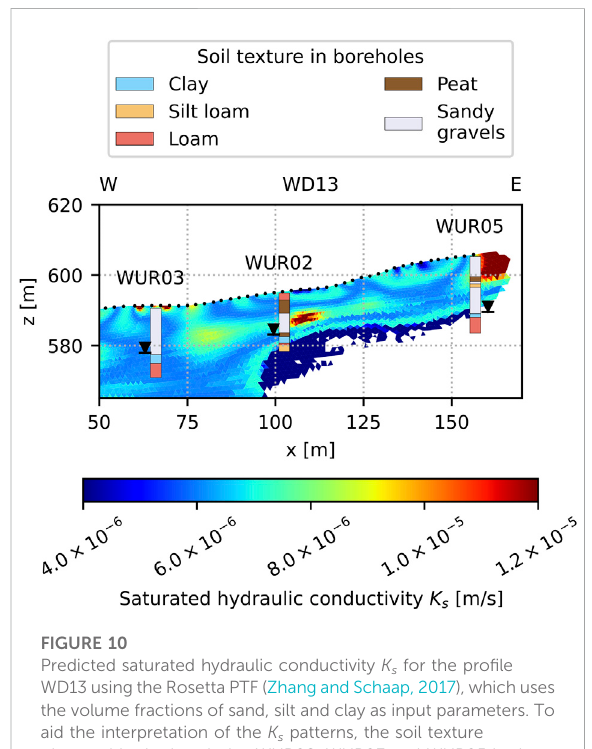
FIGURE 10 Predicted saturated hydraulic conductivity K s for the pro fi le WD13using theRosettaPTF (Zhang andSchaap, 2017),which uses the volume fractions of sand, silt and clay as input parameters. To aid the interpretation of the K s patterns, the soil texture observed in the boreholes WUR02, WUR03 and WUR05 is also presented. The reversed black triangles indicate the water tables reported during